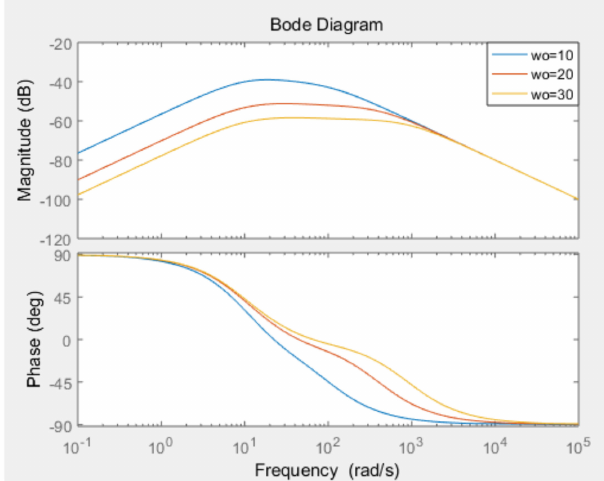
Figure 13. Bode diagram analysis of system disturbance term ( ω o